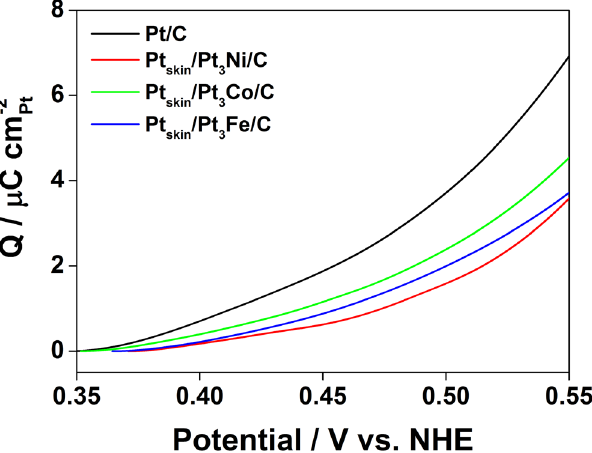
Figure 3. Evaluation of phosphoric acid adsorption charge density. Accumulated charge density profiles of Pt/C, Pt skin /Pt 3 Ni/C, Pt skin /Pt 3 Co/C, and Pt skin /Pt 3